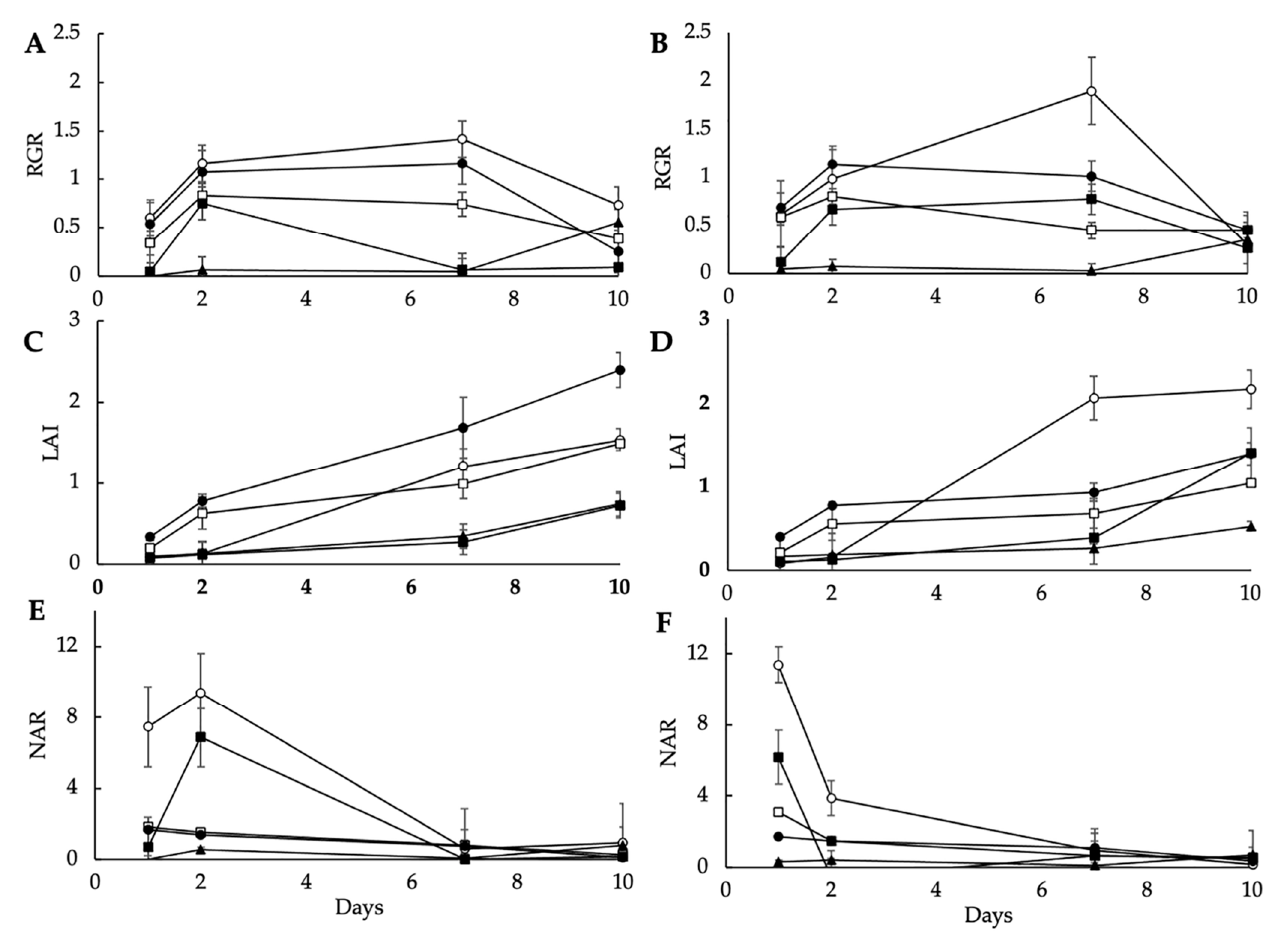
Figure 2. Relative growth rate (RGR: g/m 2 surface area/day) under LED ( A ) and fluorescent lighting ( B ), leaf area index (LAI: m 2 leaf area/m 2 surface area) under LED ( C ) and fluorescent lighting ( D ), and net assimilation rate (NAR: g/m 2 /day) under LED ( E ) and fluorescent lighting ( F ), of green pea ( ■ ), radish ( ● ), Red Rambo (RR, □ ), soybean (soy, ), and rocket ▲ ( ) microgreens over a 10 day period. Values are the mean ± SD of three replicates ( n = 3).